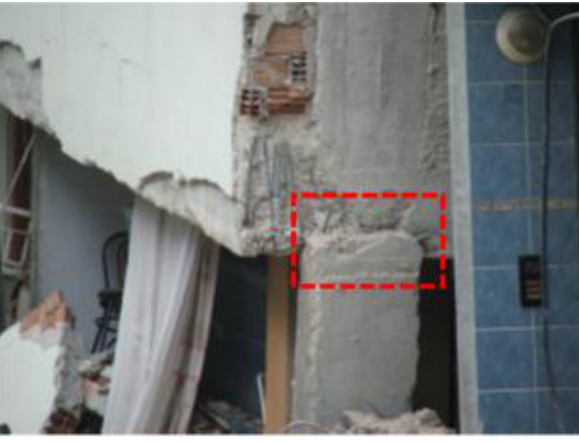
Figure 13. Inadequate transverse reinforcement in beam-column joints.